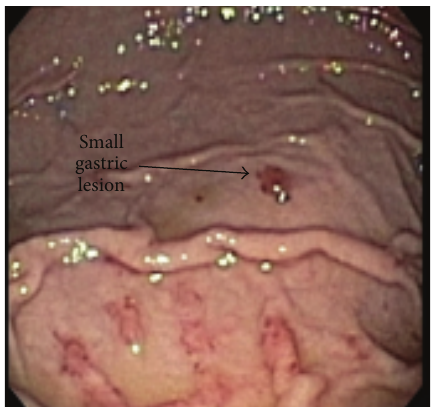
Figure 2: Small gastric